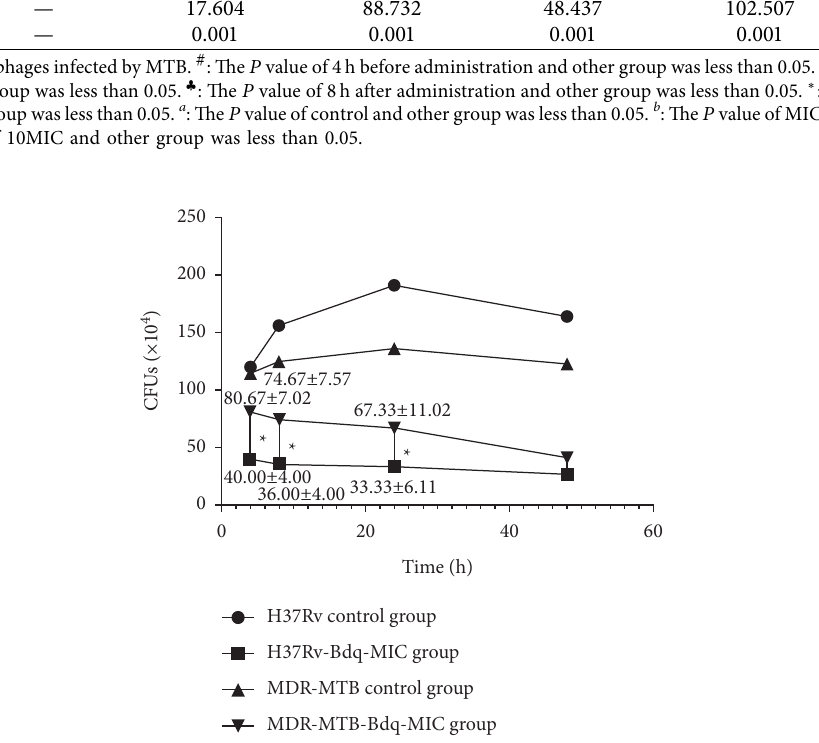
Table 2: Intracellular CFUs detected in macrophages infected with H37Rv and MDR-MTB strains after Bdq treatment ( x ± s ) .